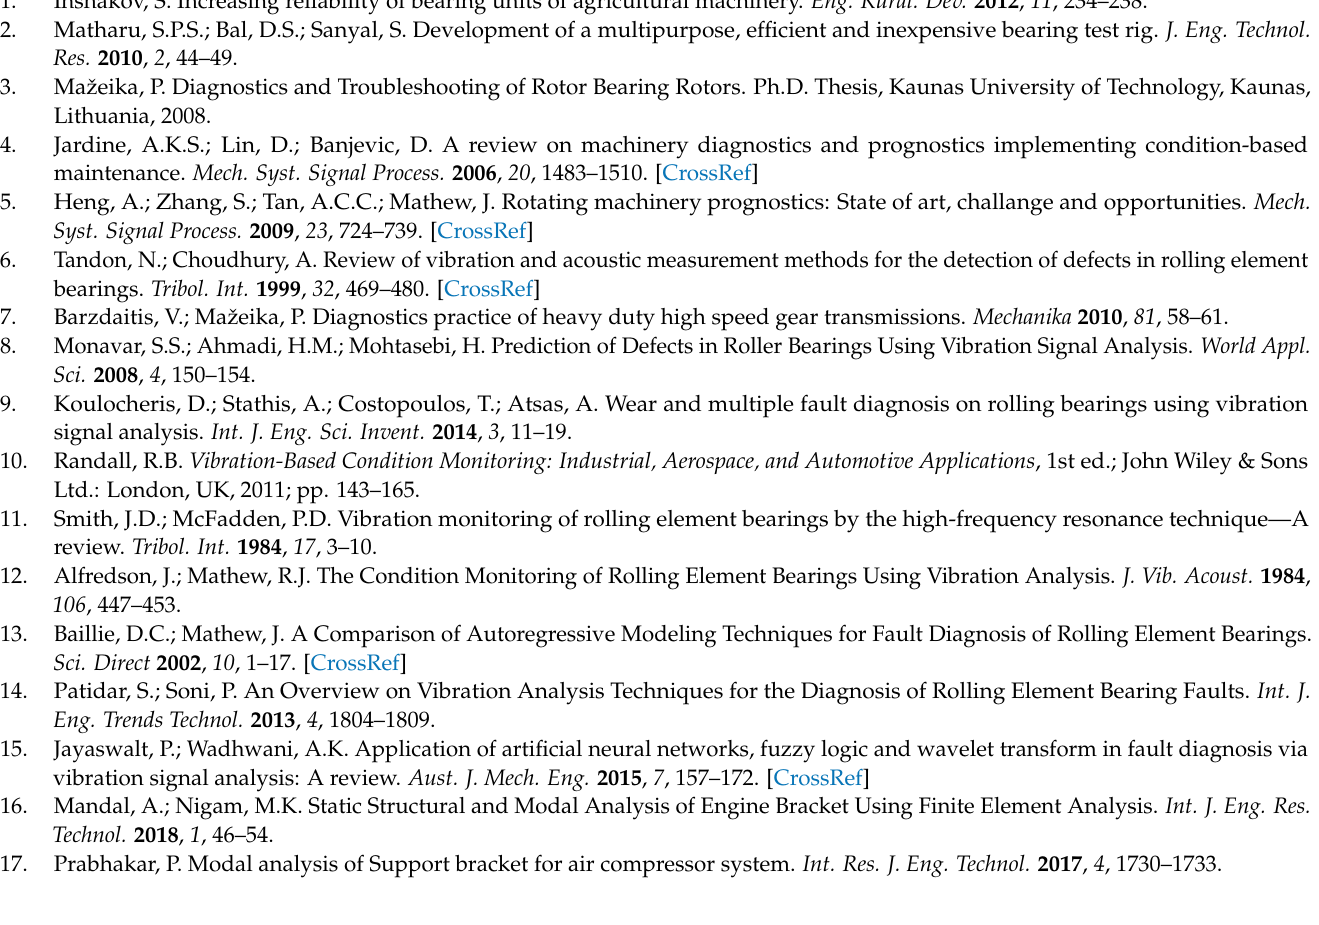
Figure A2. 20213 k TVP C3 bearing dimensions.